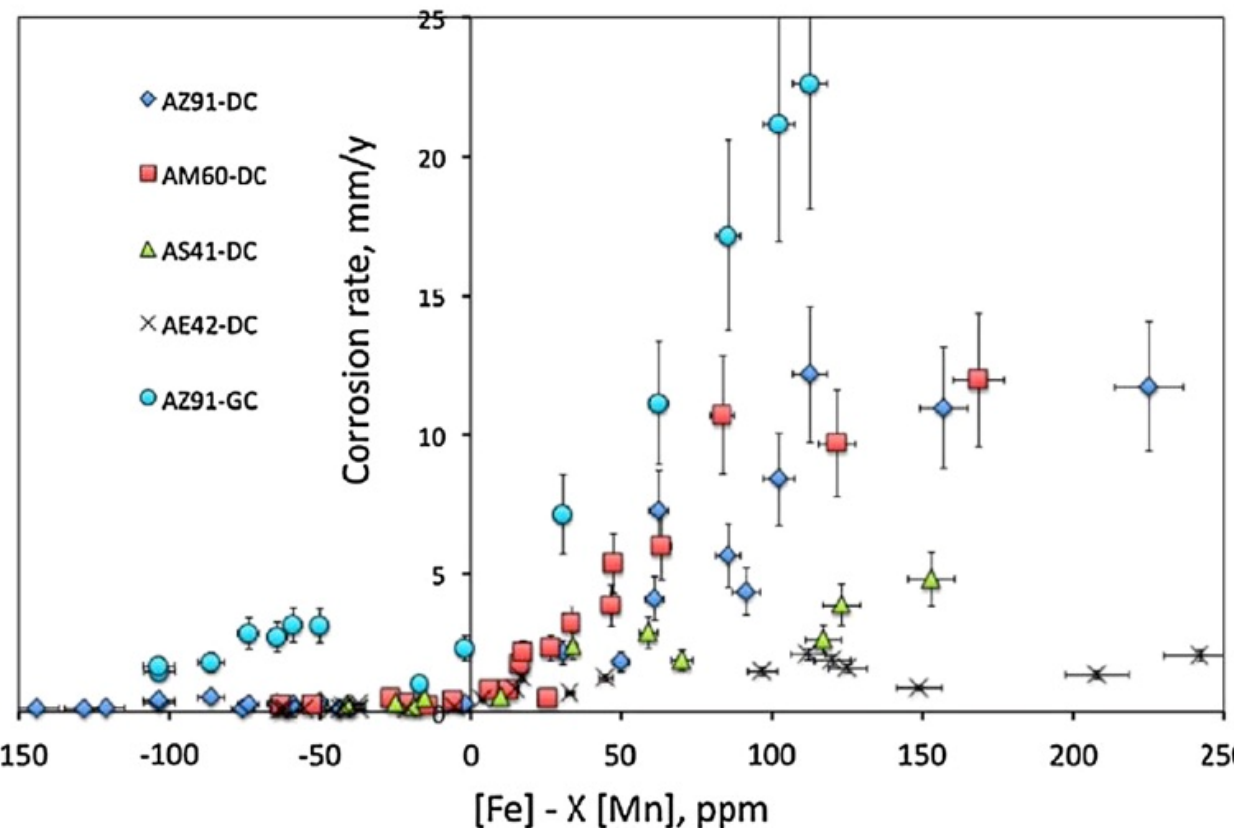
Figure 6. Data [84] indicate high corrosion rates above the compositional dependent tolerance limit (i.e., for positive values on the variable plotted on the X -axis), and a low corrosion rates for compositions below the tolerance limit (i.e., for negative values of the X -axis).